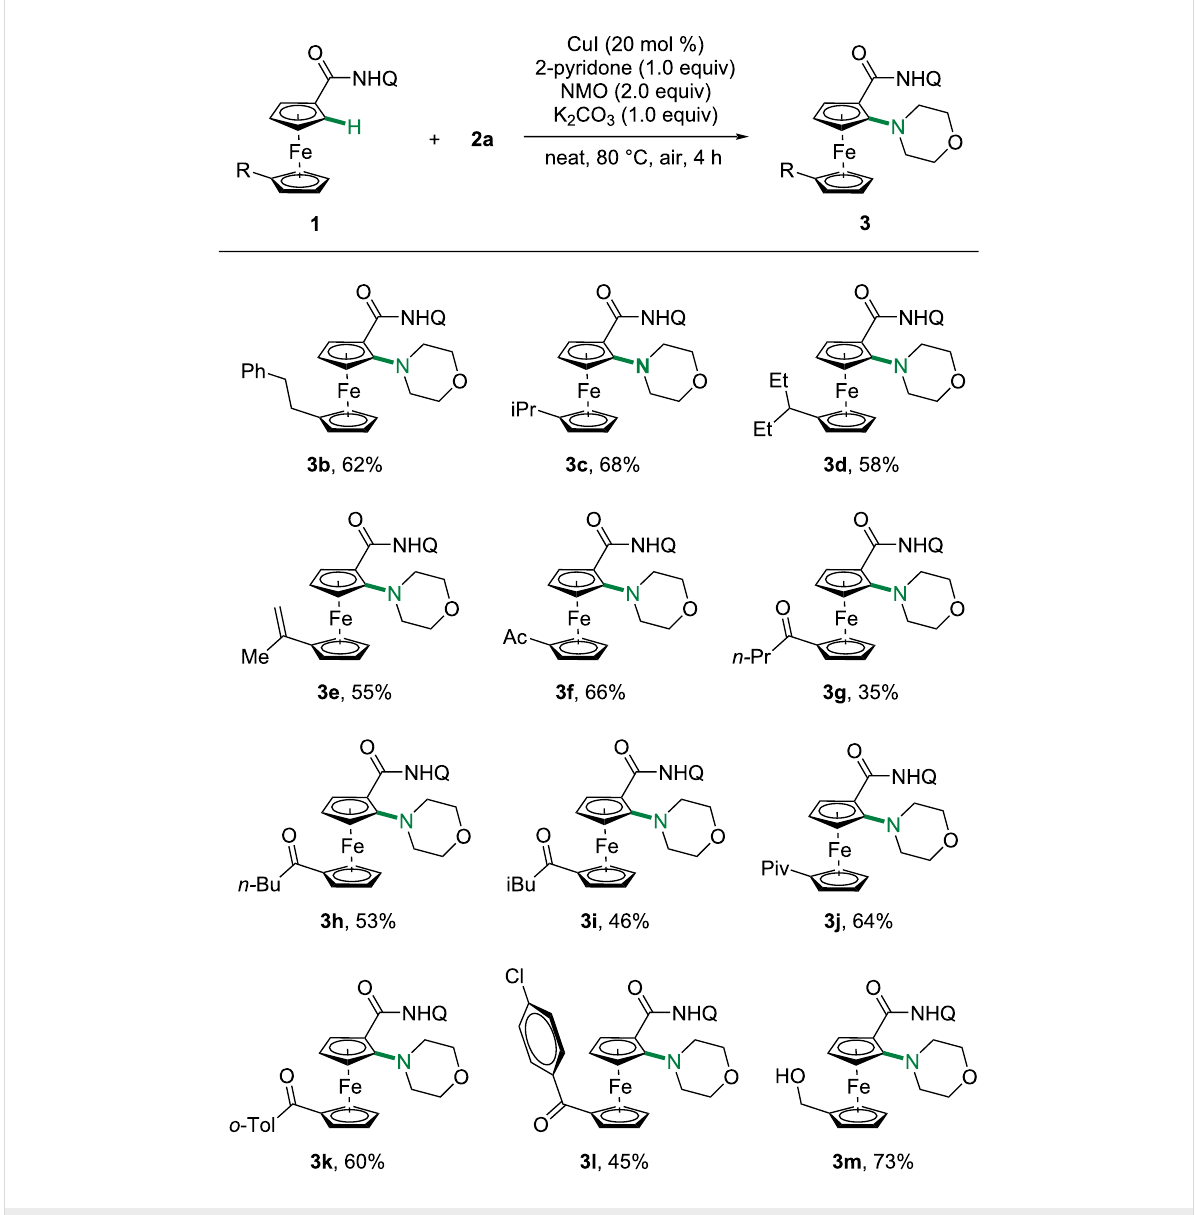
Scheme 2: Scope of ferrocenes with